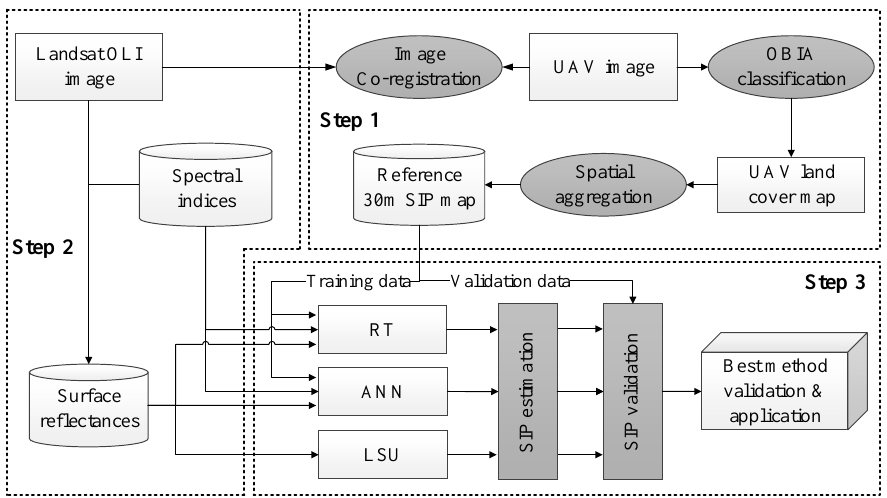
Figure 3. Flowchart of the overall approach for mapping the subpixel inundation percentage (SIP), using data on the Landsat-8 Operational Land Imager (OLI) and unmanned aerial vehicle (UAV). The RT, ANN, and LSU are the abbreviations of regression tree, artificial neural networks, and linear spectral unmixing, respectively.